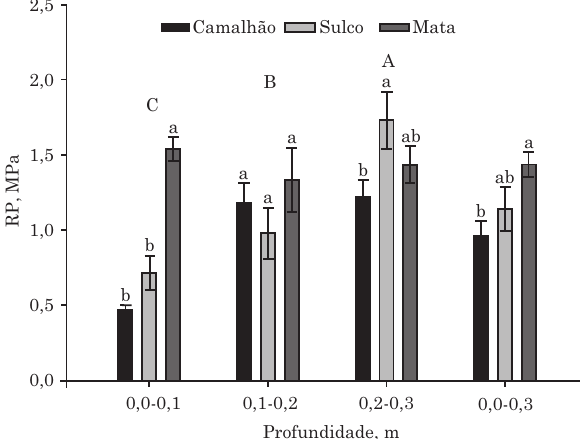
Figura 3. Resistência do solo à penetração, com os desvios-padrão da média, para as áreas cultivadas com mamoeiro e mata nativa secundária. Médias seguidas pela mesma letra maiúscula entre profundidades, e pela mesma letra minúscula na mesma profundidade, não diferem pelo teste de Tukey a 5 %.